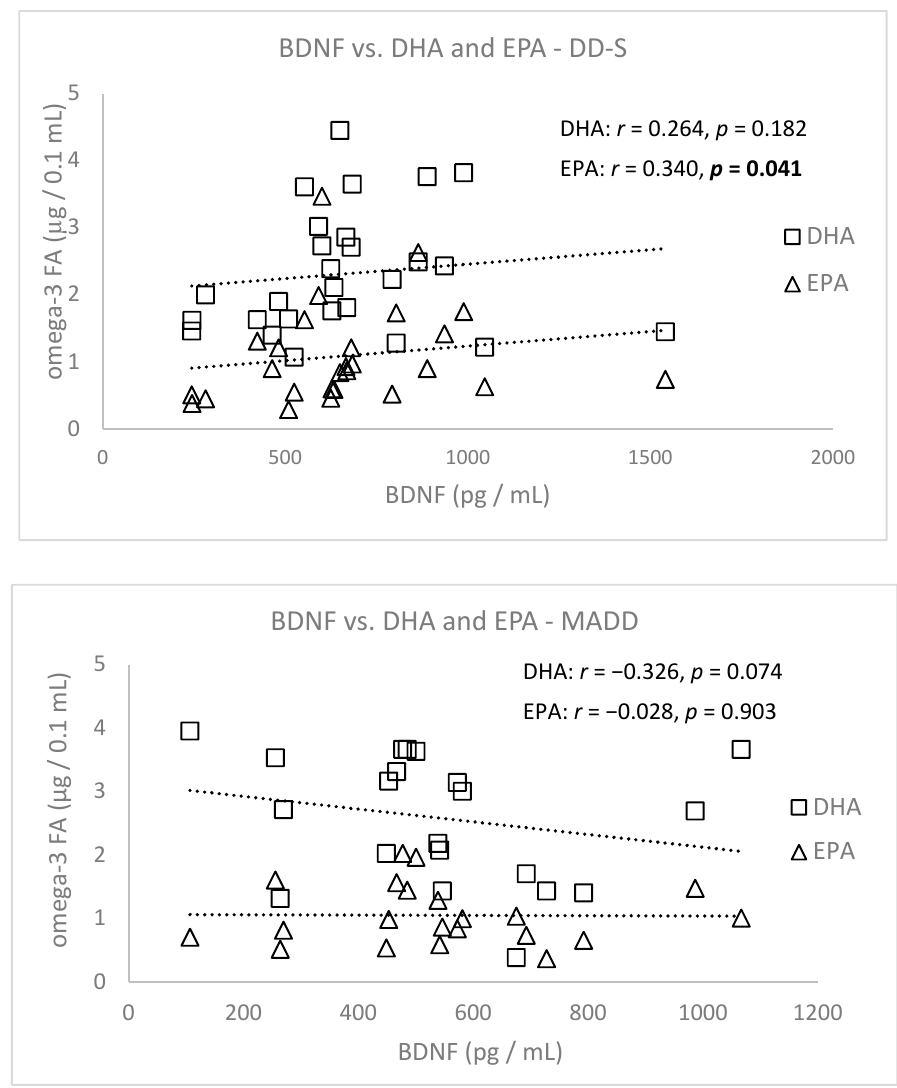
Figure 6. Correlations of BDNF with DHA and EPA in patients from the depressive disorder subgroup (DD-S, without mixed anxiety and depressive disorder (MADD)) and the MADD group. BDNF = brain derived neurotrophic factor, DHA = docosahexaenoic acid, EPA = eicosapentaenoic acid.